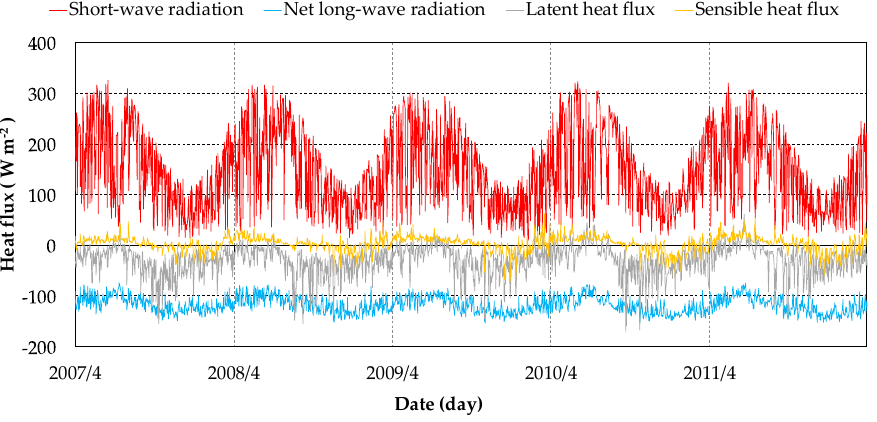
Figure 4. Time series of short-wave radiation, net long-wave radiation, latent heat flux, and sensible heat flux from 2007 to 2012.